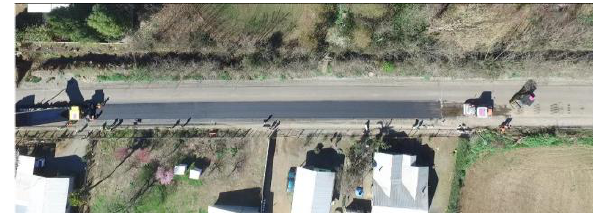
Figure 1. View on the construction site and machinery